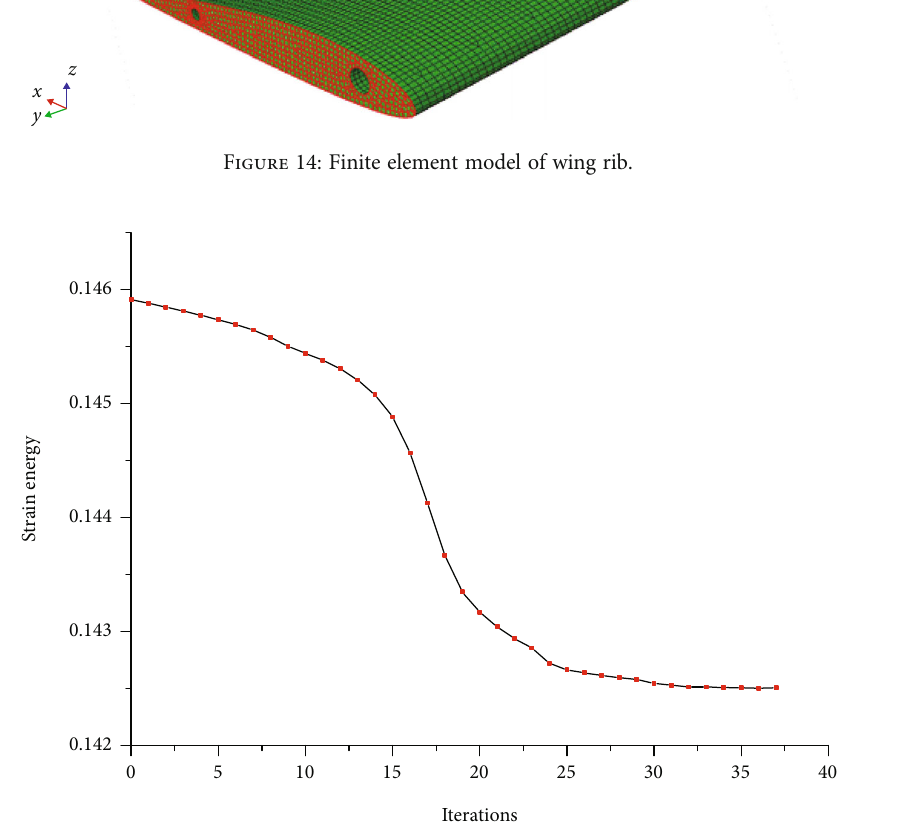
Figure 15: The change process of strain energy of wing rib.